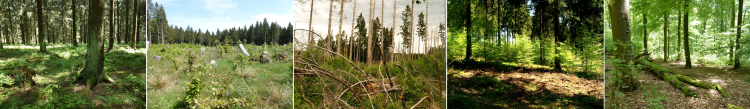
Impressions of the five forest conversion stages (from left to right): Norway spruce forest, salvage-logged spruce windthrow, unmanaged spruce windthrow, close-to-nature managed spruce/beech mixed forest, and European beech forest.